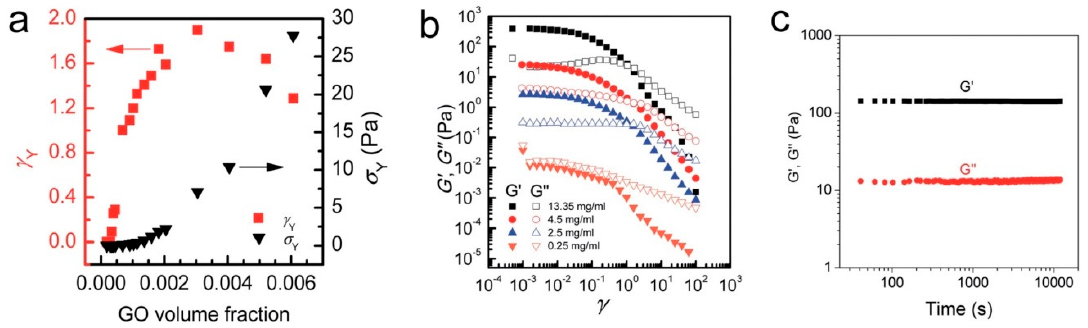
Figure 16. Fingerprints of the rheological characteristic of LC GO dispersions. ( a ) Yied stress ( σ Y) and yield strain ( γ Y) versus GO volume fraction. ( b ) Storage and loss moduli of GO suspensions versus strains (frequency of 0.01 Hz). ( c ) No aging after shear fluidization can be observed. Adapted from [204], with permission from The Royal Society of Chemistry, 2014.